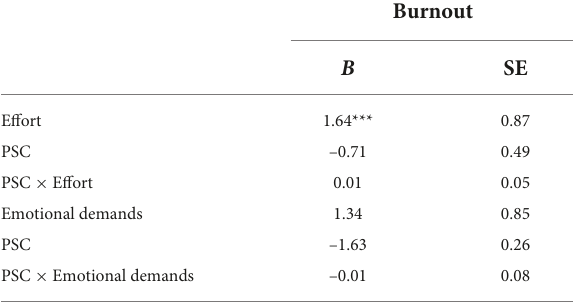
TABLE 6 Multilevel random coefficient model (adjusted for gender and age) to test moderation